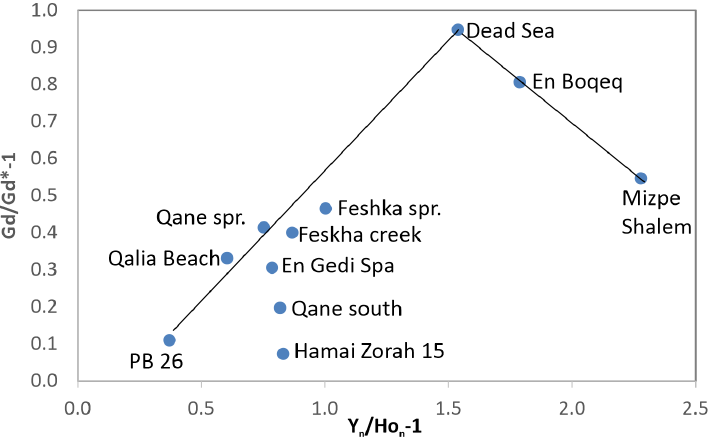
Figure 11. Cross plots of Gd and Y anomalies in Dead Sea brineinfiltrated into limestones [65]. The systematic changes in brine composition are indicated by the trend of Dead Sea-Mizpe Shalem. The composition of samples not lying on one of the two trends may be related to the dilution line similar to Mizpe